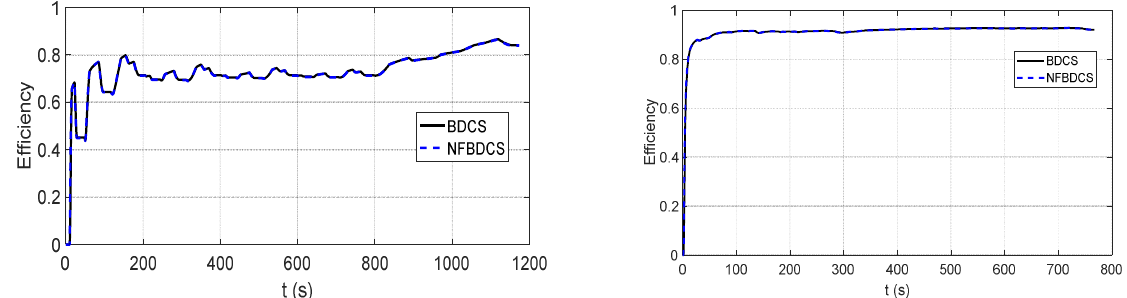
Figure 25. Energy efficiency for NEDC ( left ) and HWFET ( right ) driving cycles.